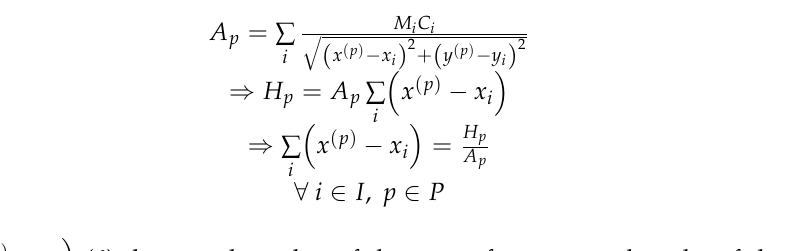
Figure 3. Calculation of the direct distance between places in the distribution region.